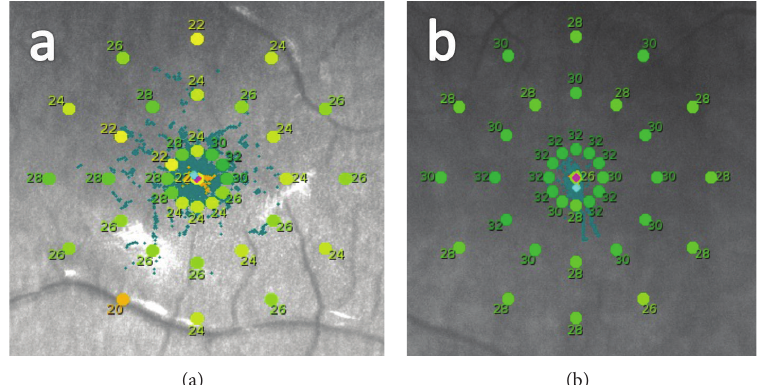
Figure 1: Examples of sensitivity maps obtained with the MAIA MP system: (a) sensitivity map of a patient under treatment with HCQ (group B); (b) sensitivity map of a healthy patient (group A).